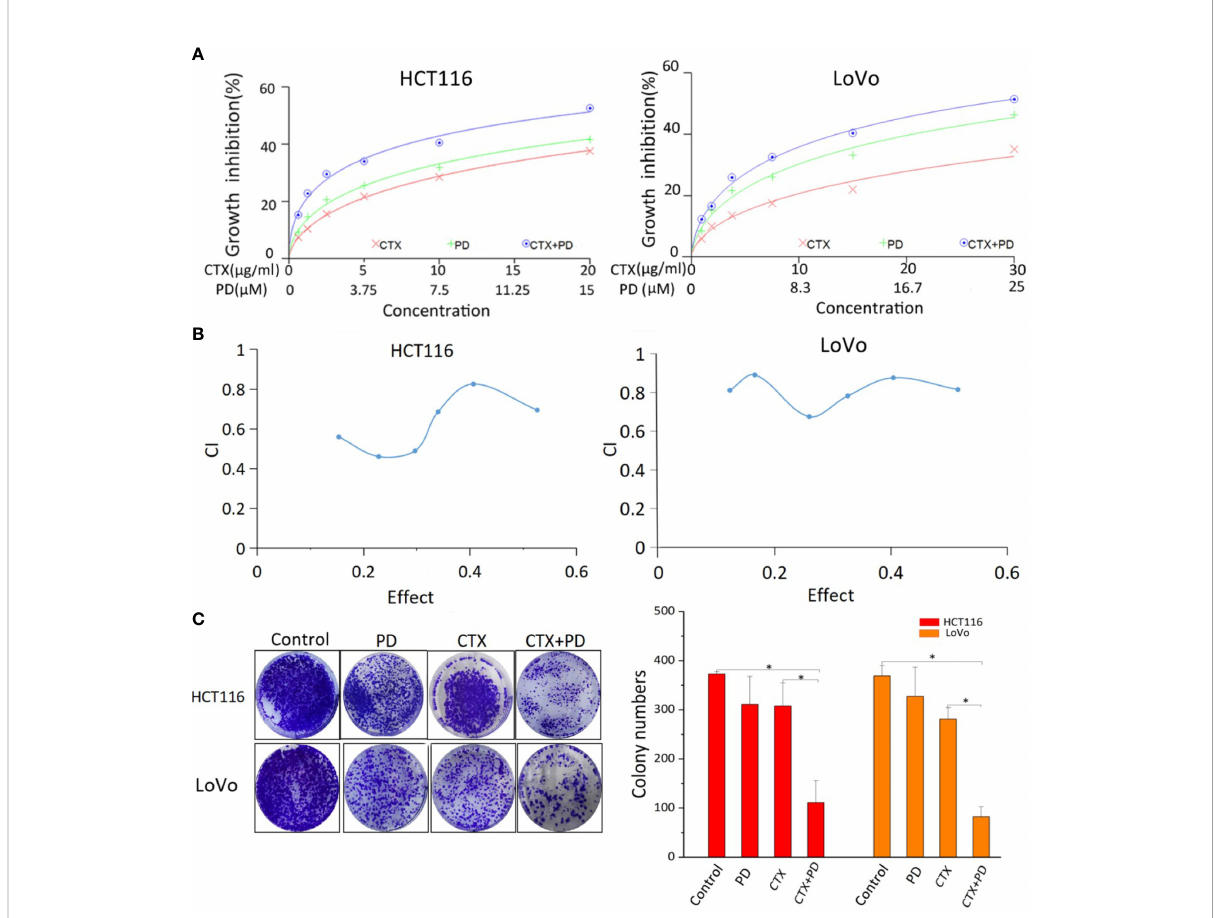
FIGURE 1 Results of CCK-8 and colony formation assays of PD- and CTX-treated cells. (A) The inhibitory effects of PD and/or CTX treatment in HCT116 and LoVo cells were examined by CCK-8 assay after treatment for 48 h. (B) The results of CCK-8 assay were analyzed with the CalcuSyn software. Combination Index (CI) was calculated by the Calcusyn software. CI < 1 was considered synergistic, CI = 1 additive, and CI > 1 antagonistic cytotoxicity. (C) The colony-formation assay was performed, and the results are displayed as colony numbers. Columns showed mean ± S.D. ‘ Control ’ was compared with the other groups, ‘ CTX ’ was compared with ‘ CTX+PD ’ using one-way ANOVA. * P < 0.05 represents a signi fi cant